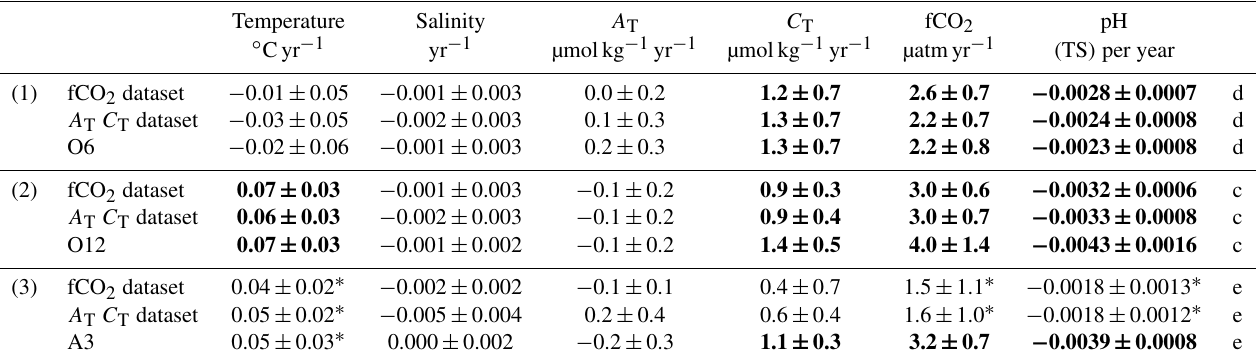
Table 4. Trends (per year) evaluated in the phytoplanktonic bloom of (1) Crozet in the PFZ and of Kerguelen in the (2) PFZ and (3) POOZ, from the fCO 2 surface dataset, the A T and C T surface dataset, and the A T and C T data in the mixed layer at each station (O6, O12 and A3), estimated between (c) 1999 and 2019, (d) 2000 and 2019, and (e) 2005 and 2019. The significant trends (Student’s t test) are represented in bold (at 95%) or with a star (at